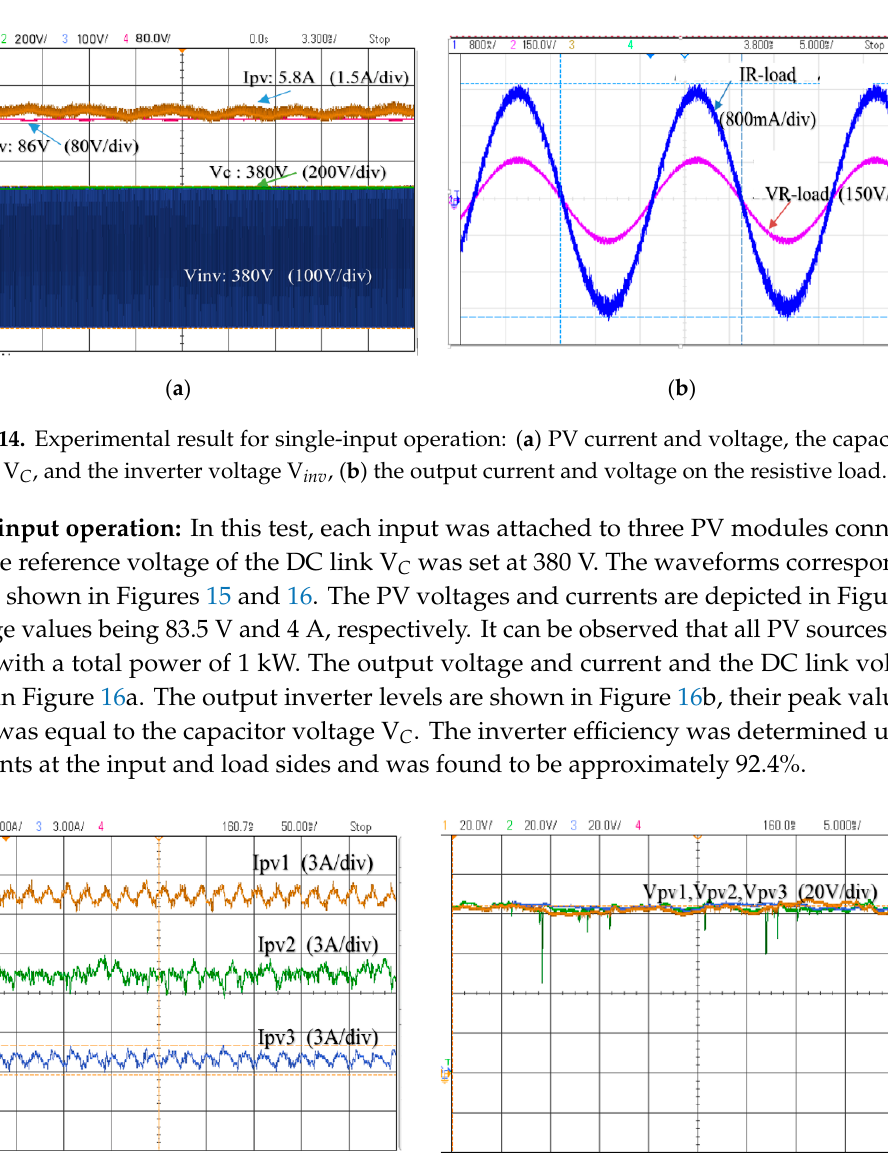
Figure 16. Experimental result for multi-input operation: ( a ) the capacitor voltage V C , the output current and voltage on the resistive load, ( b ) the inverter voltage levels.